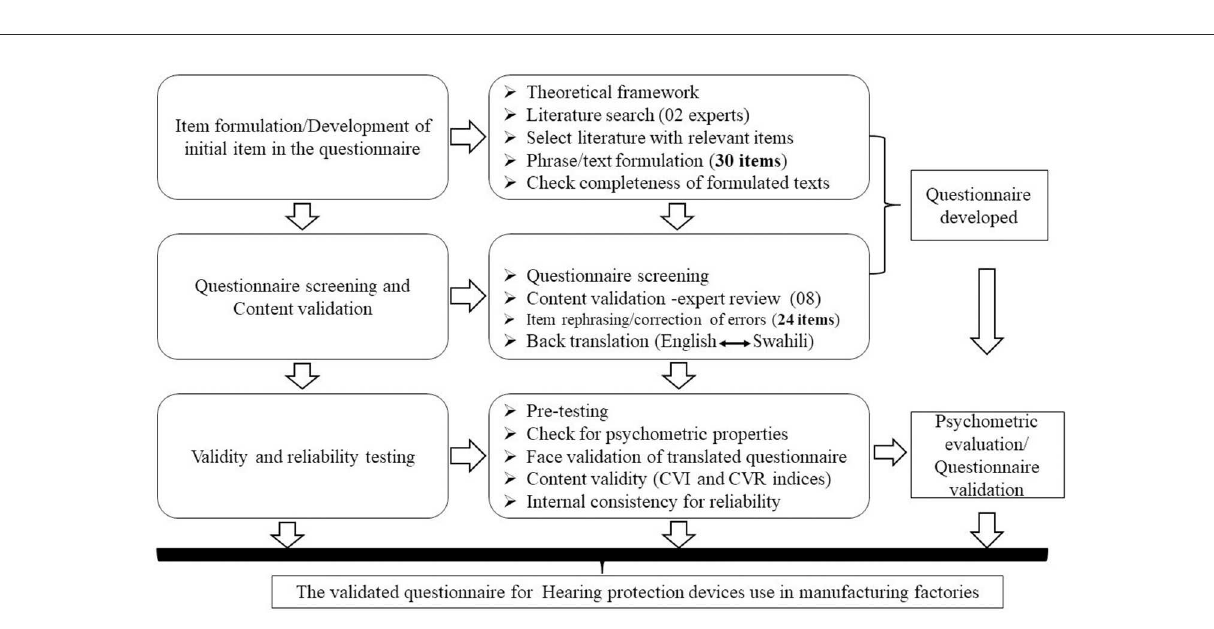
FIGURE2 Schematic diagram showing stepwise development of hearing protection devices use among workers in manufacturing factories in